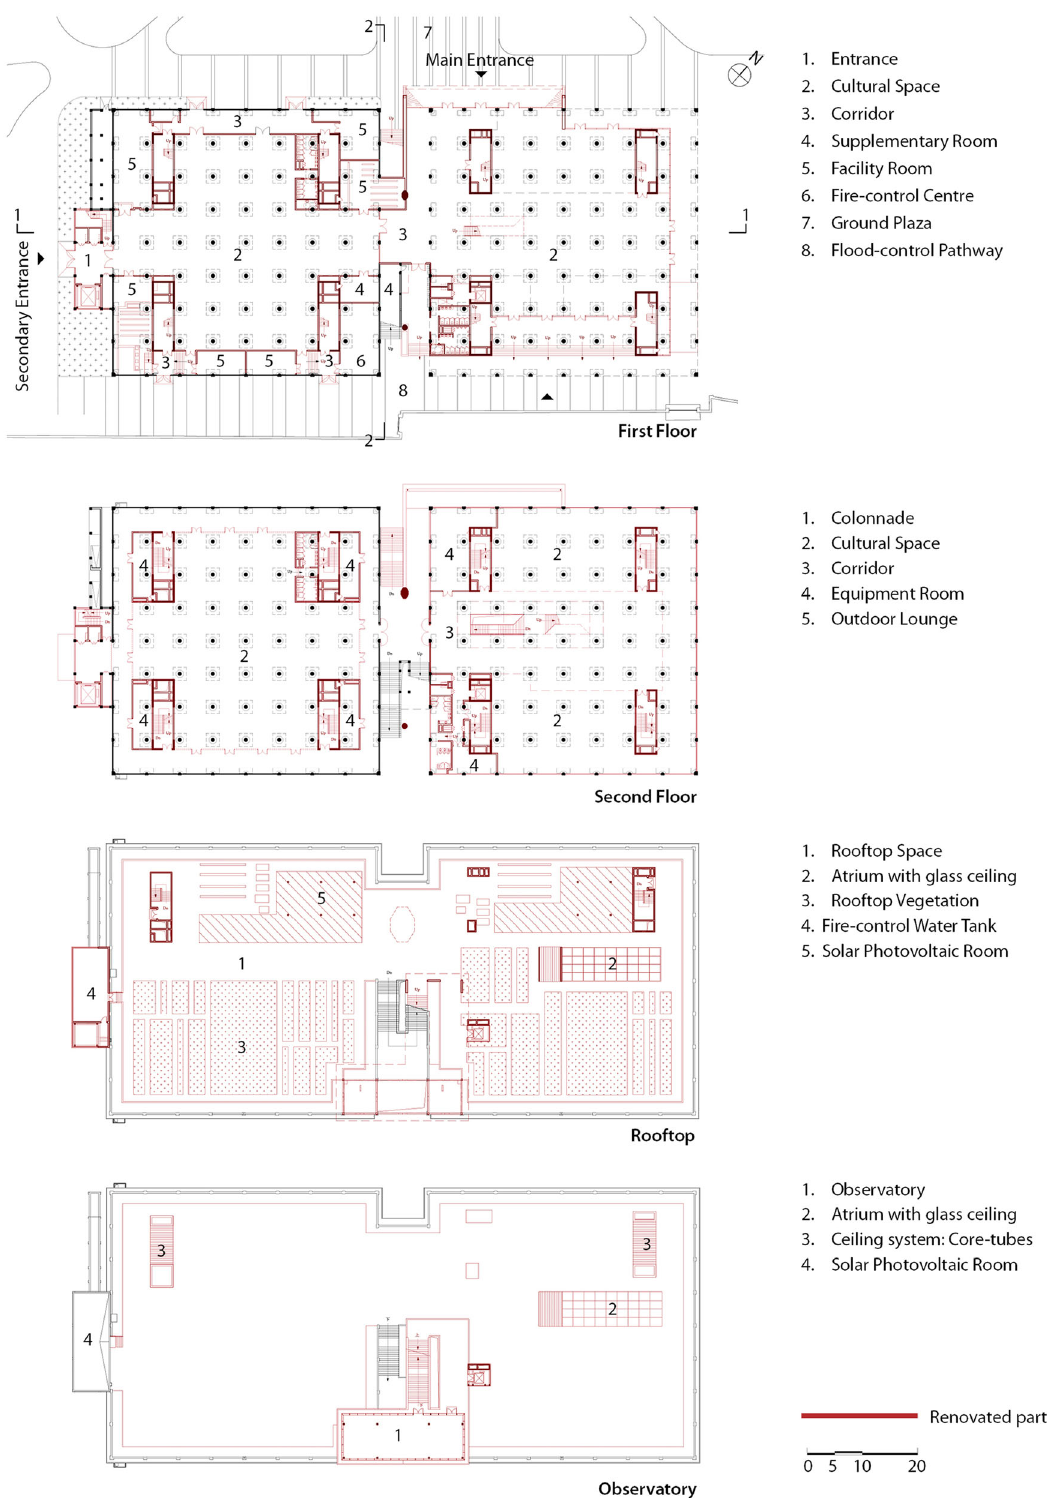
Fig. 7 Plans of the Yong ’ an Warehouse renovation (Source: Archi-Union